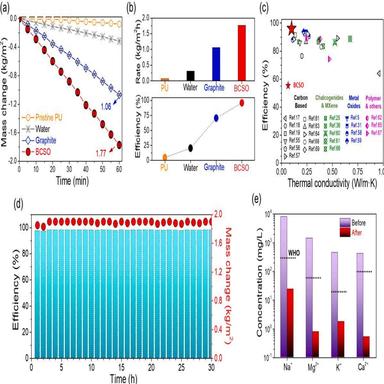
Solar to steam generation performances: (a) Change in water mass measured under simulated sunlight (i.e., 1 sun) illumination, (b) Solar steam generation efficiency and evaporation rates, (c) Plot of solar steam generation efficiency vs. thermal conductivity, (d) Stability test (30 h) of BCSO-coated PU device, and (e) Comparison of ionic concentration before and after the saline water purification process, using the BCSO-coated PU device.